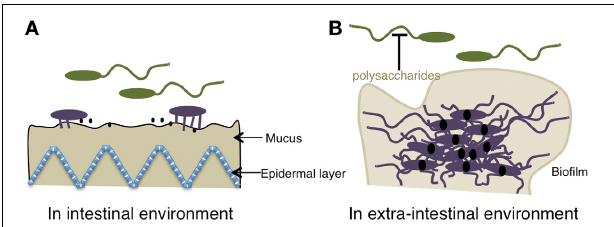
FIGURE 6 | Relationship between the motility of the polar flagellum of Vibrio and pathogenicity. (A) In an intestinal environment, because of the presence of bile, the gene expression of virulence is “OFF.” When the polar flagellum senses the high viscosity of the mucus gel, the motility is blocked, lateral flagella or pili are induced, and pathogenic gene expression, including toxins (black solid dots) is kept “ON” presumably because of the reduced bile concentration. (B) In an extra-intestinal environment, c-di-GMP (solid black dots) facilitates Vibrio from the motile-to-sessile transition by decreasing migration due to the binding of the YcgR homolog to the flagellar motor, which causes a reduction of motility and induces the biofilm formation and the suppression on the motility by releasing a lots of polysaccharides. The schemes are drawn based on previous reports (Krasteva et al., 2010; Boyd and O’Toole,